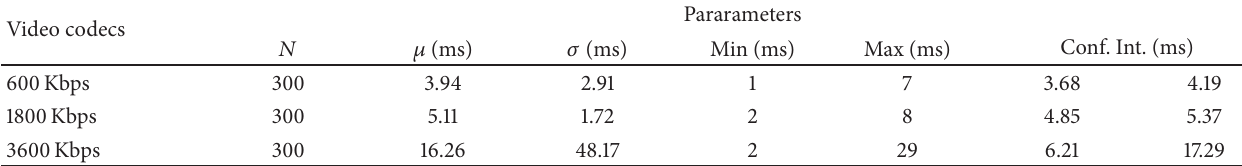
Table 3: Statistical values of the jitter of different streams using different codecs.